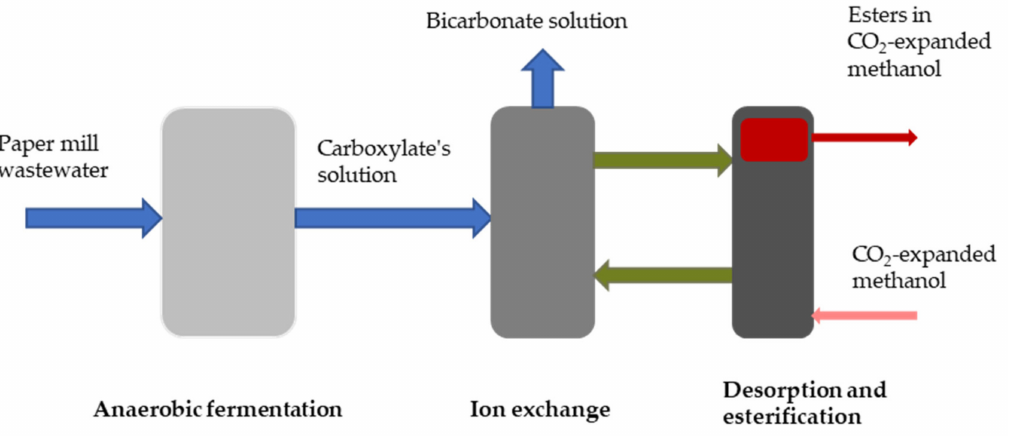
Figure 5. Integrated recovery and esterification of the carboxylate from a fermentation broth by CO 2 - expanded methanol technique and using paper mill wastewater as a feedstock, redrawn from